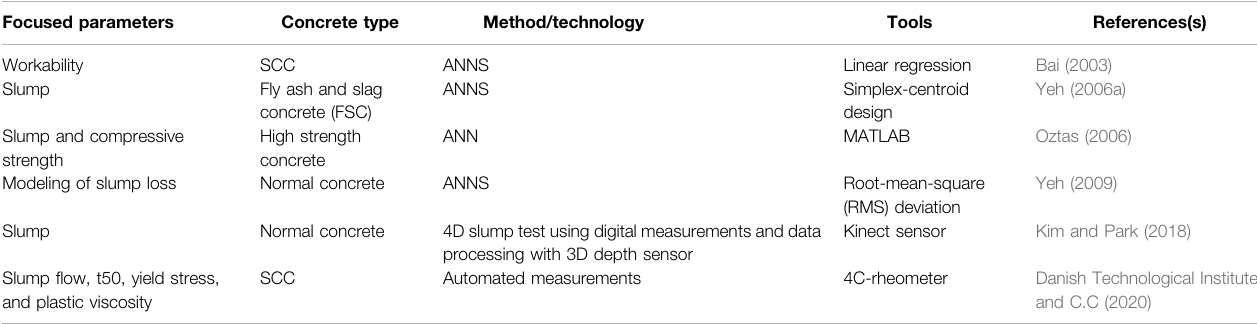
TABLE 5 | Digital transformation of workability measurement in